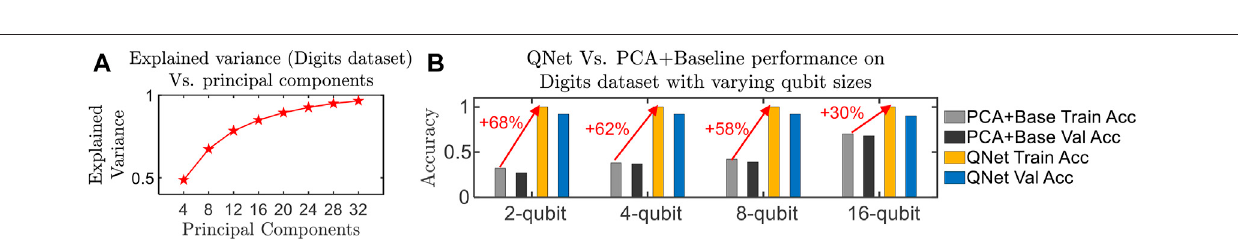
FIGURE 8 | The PCA + Baseline model performance largely depends on the chosen number of principal components (PC). A higher number of PC captures more varianceoftheinputdata. (A) showsthefractionofexplainedvariancewithanincreasingnumberofPC. (B) showstheperformanceofPCA+BaselineagainstQNetwith varying numbers of PC (after 20 epochs of training in a noiseless simulator). n-qubit corresponds to n chosen PC for the PCA + Baseline models and QQ (cid:2) n for the corresponding QNet models (both can be executed on n-qubit hardware). In QNet, we use PL (cid:2) 2, QL (cid:2) 2. For a fair comparison, we vary the number of trainable parameters in PCA + Baseline models and report the best-measured performance against